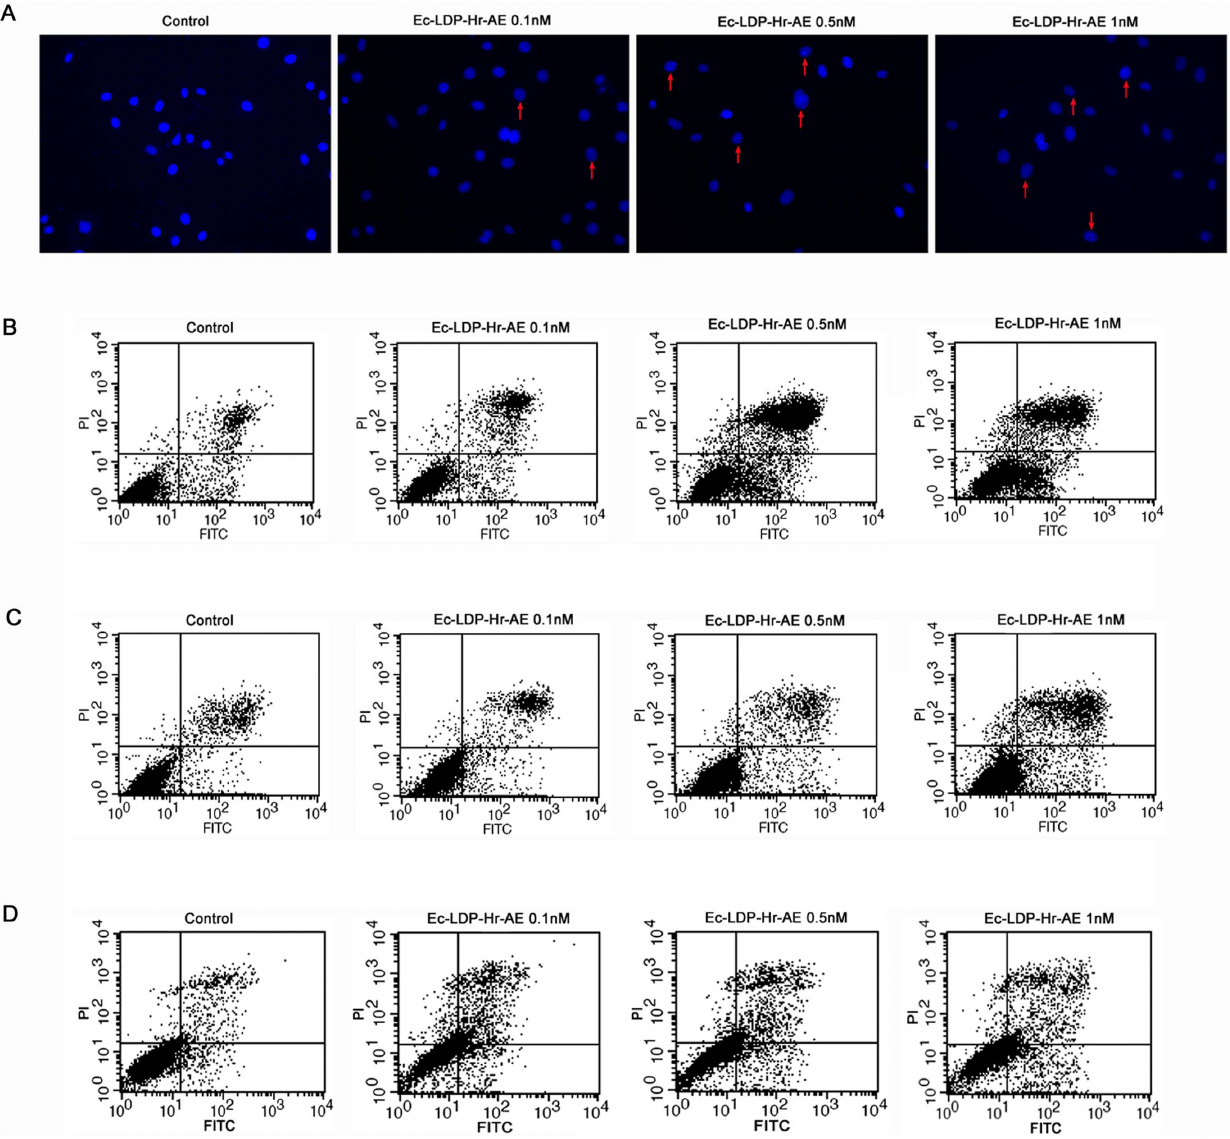
Figure 4. The effects of apoptosis-induction by Ec-LDP-Hr-AE treatment. (A) KYSE150 cells were treated by Ec-LDP-Hr-AE at indicated concentrations for 48 h, and then stained by Hoechst 33342. The images were observed under a fluorescence microscope at 6 200. EC9706 cells (B), KYSE150 cells (C) or NIH 3T3 cells (D) were exposed to the indicated concentrations of Ec-LDP-Hr-AE for 48 h. Cells were harvested and stained with a combination of FITC-Annexin V and PI. The lower left quadrants (FITC 2 /PI 2 ) indicated the viable cells, and the lower right quadrants (FITC + /PI 2 ) indicated the early apoptotic cells. The upper right quadrants (FITC + /PI + ) indicated the late apoptotic cells, and the upper left quadrants (FITC 2 /PI + ) indicated the dead